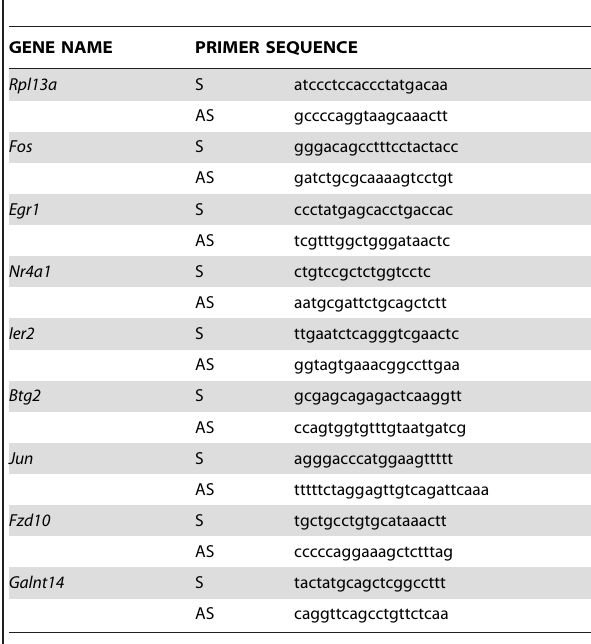
Table 2. Primers used for real-time PCR analysis (reference gene: Rpl13a